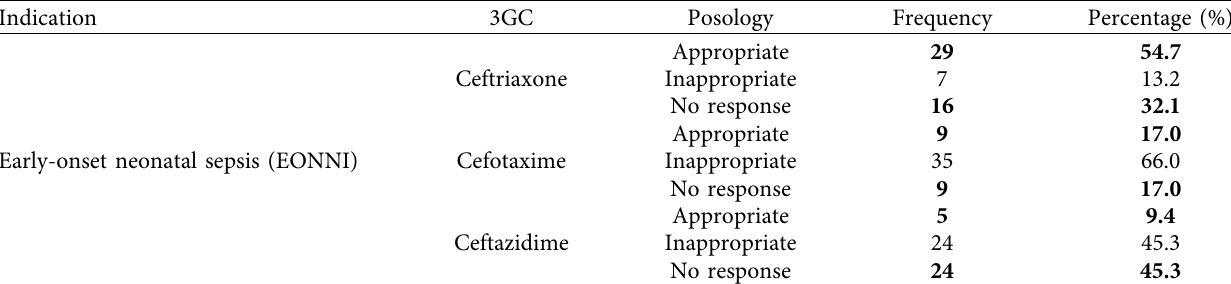
Table 4: Assessment of knowledge on posology of some 3GC in EONNI.